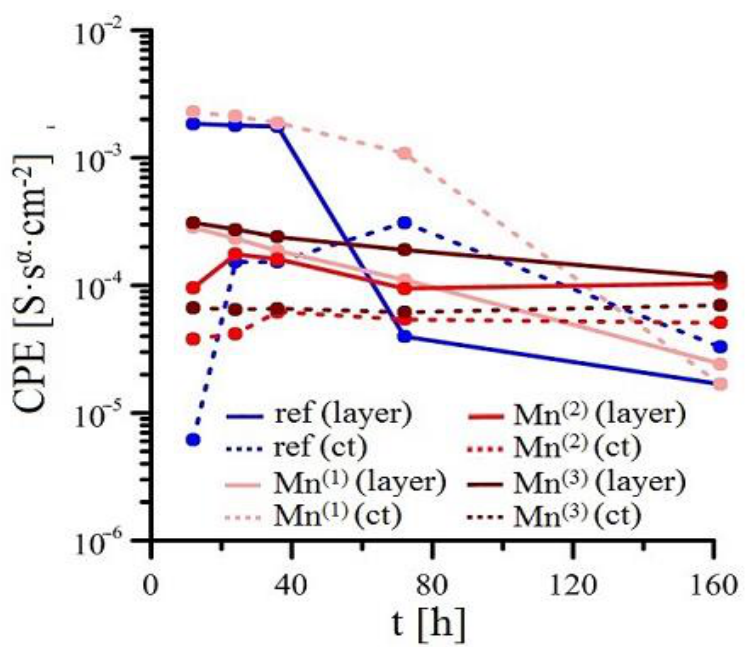
Figure 12. Point evaluation of CPE (t) EIS spectra for simulated concrete pore solution with graded amount of MnO 4 − .